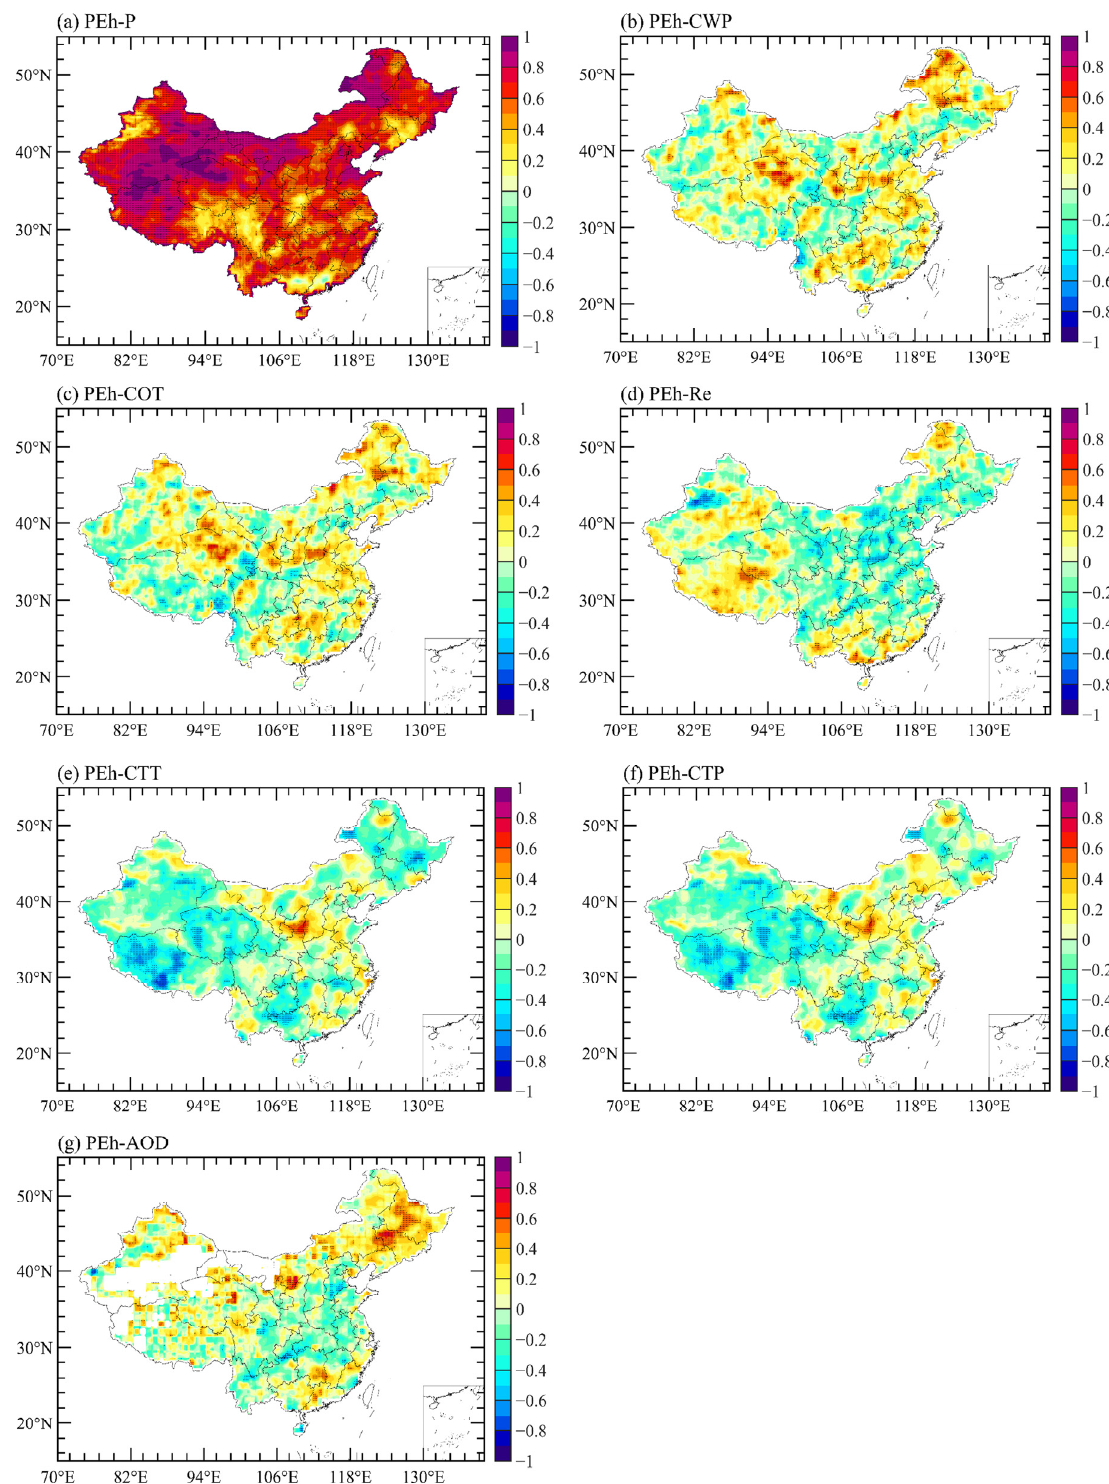
Figure 13. The correlation coefficient distribution between the PEh and ( a ) total surface precipitation (P), averaged daily ( b ) cloud water path (CWP), ( c ) cloud optical thickness (COT), ( d ) cloud effective radius (Re), ( e ) cloud top temperature (CTT), ( f ) cloud top pressure (CTP), and ( g ) aerosol optical depth over China in summer during 2001–2020. Black dots indicate the regions which passed the significance level of